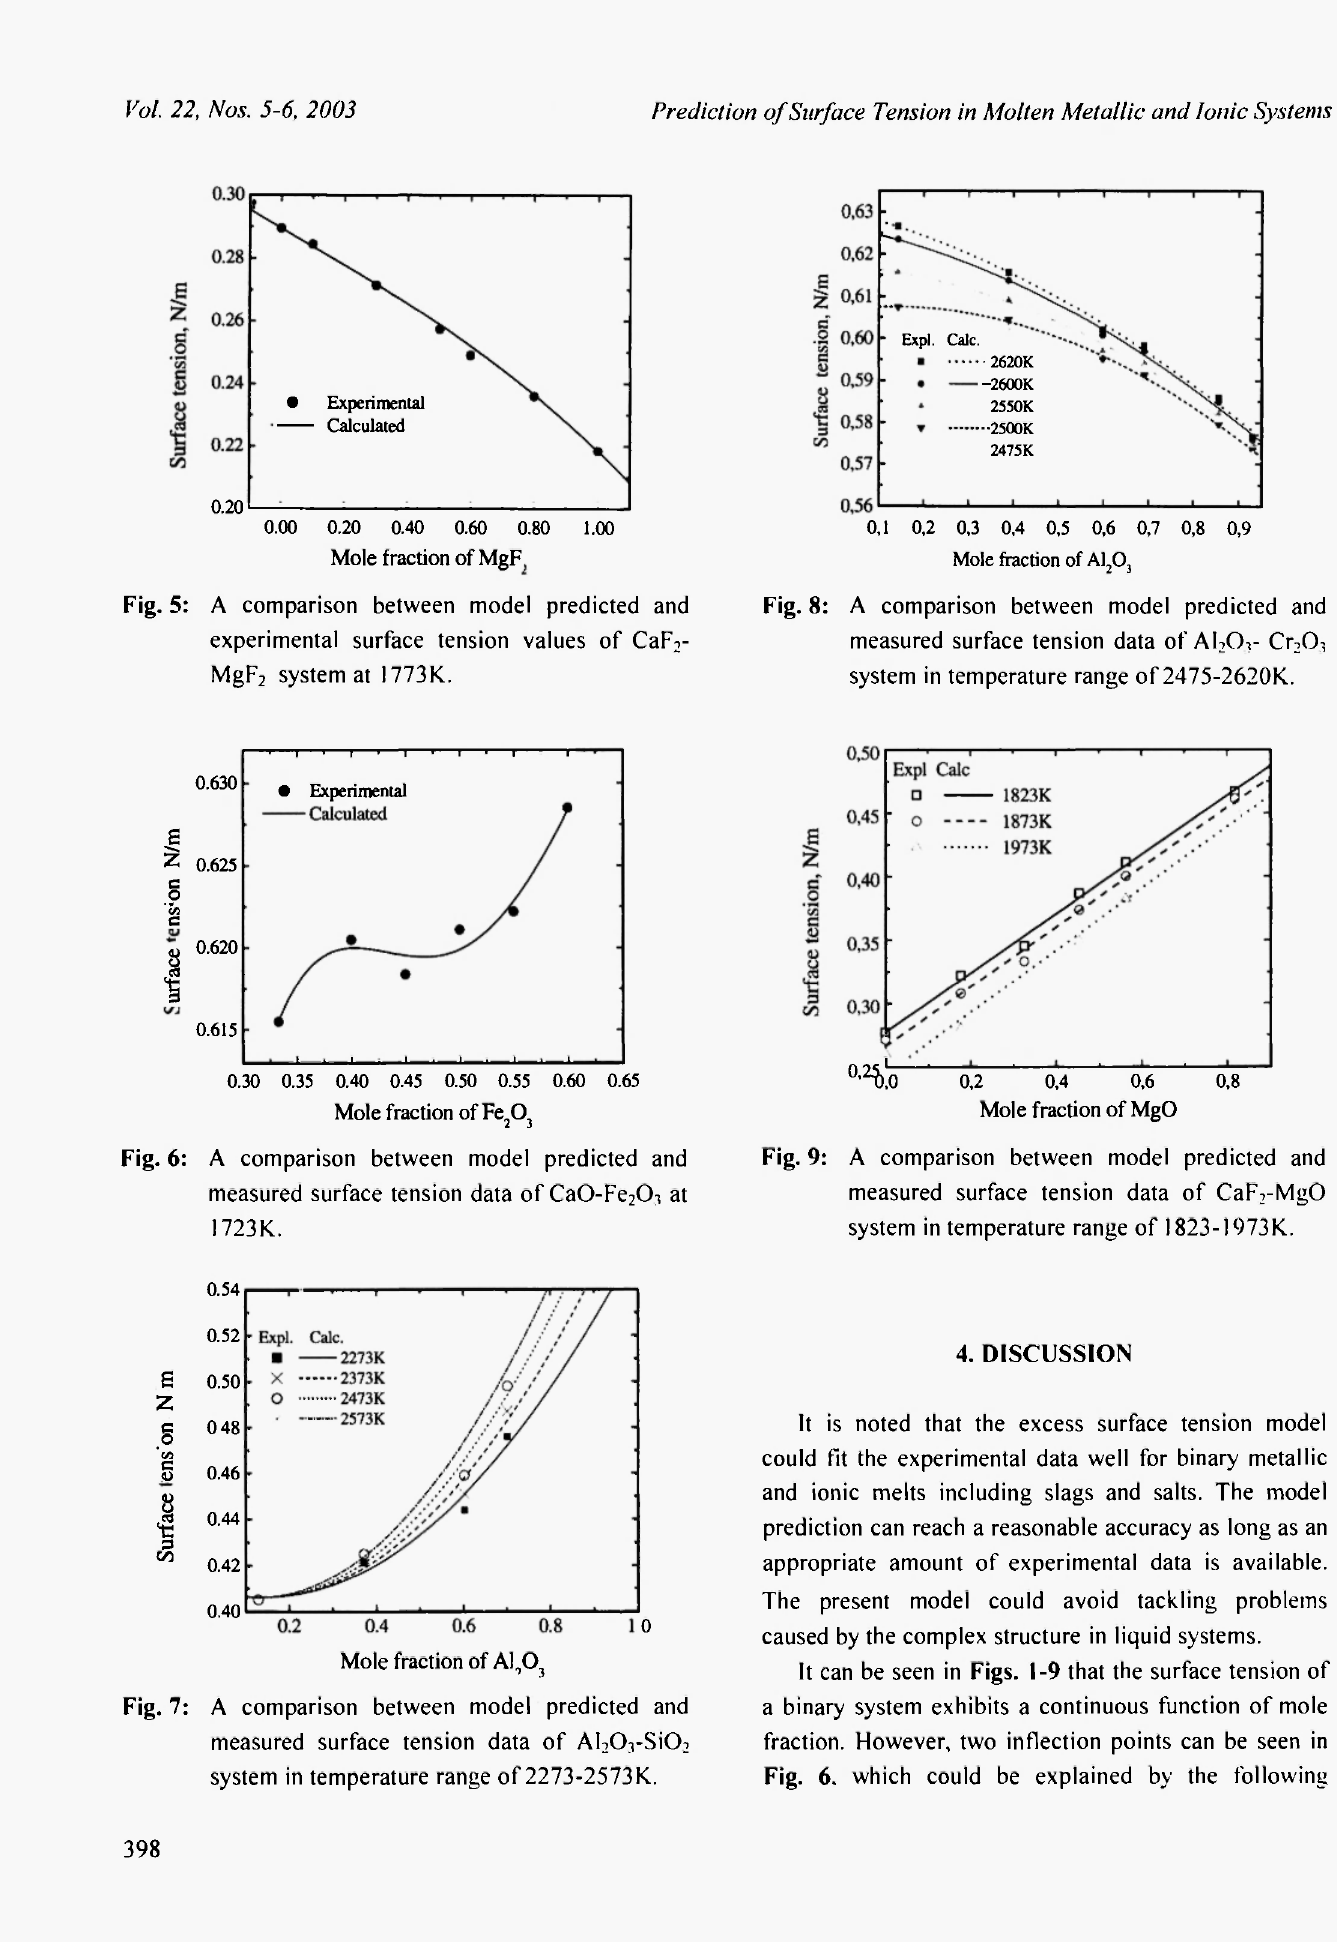
Fig. 5: A comparison between model predicted and experimental surface tension values of CaF 2 - MgF 2 system at 1773K.